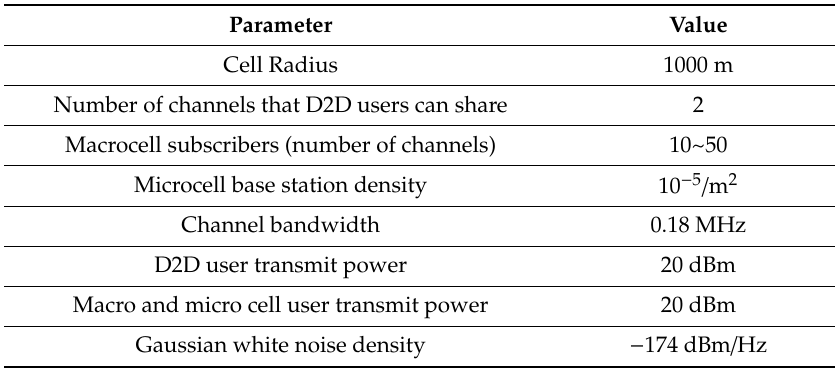
Table 2. Simulation